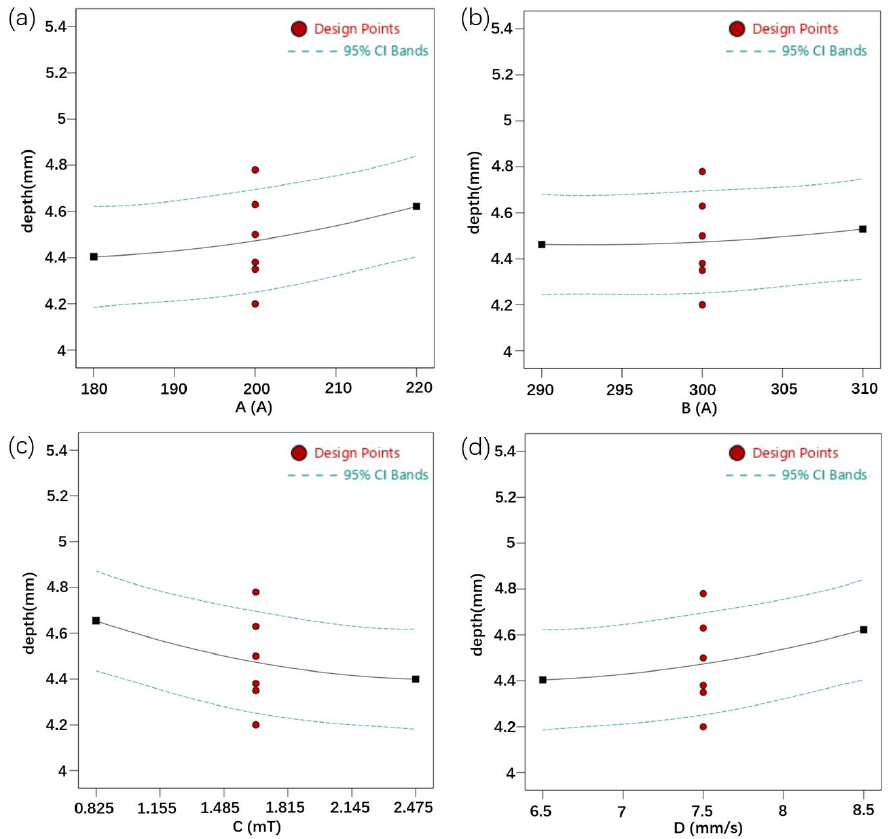
Figure 5. Influence of single factor on keyhole depth: ( a ) plasma current; ( b ) MIG current; ( c ) magnetic flux density; ( d ) welding speed.